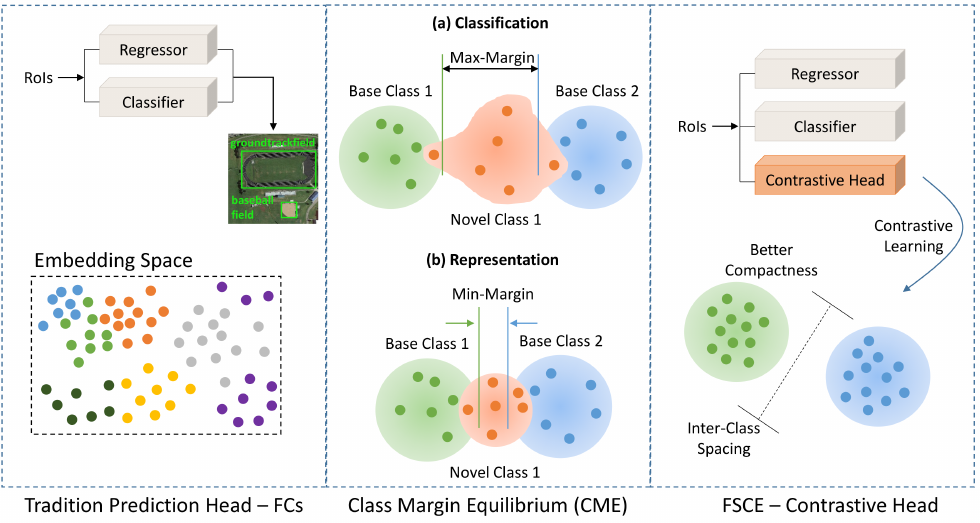
Figure 14. The principle of three kinds of few-shot prediction heads. FCs indicate fully-connected layers.